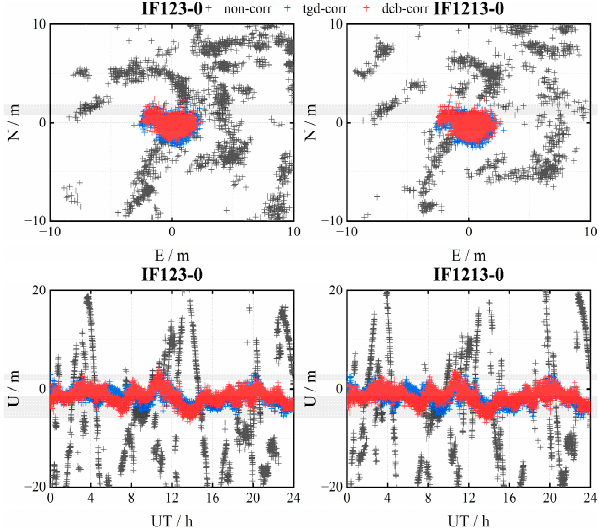
Figure 4. SPP positioning error of IF123-0 and IF1213-0 at AREG.